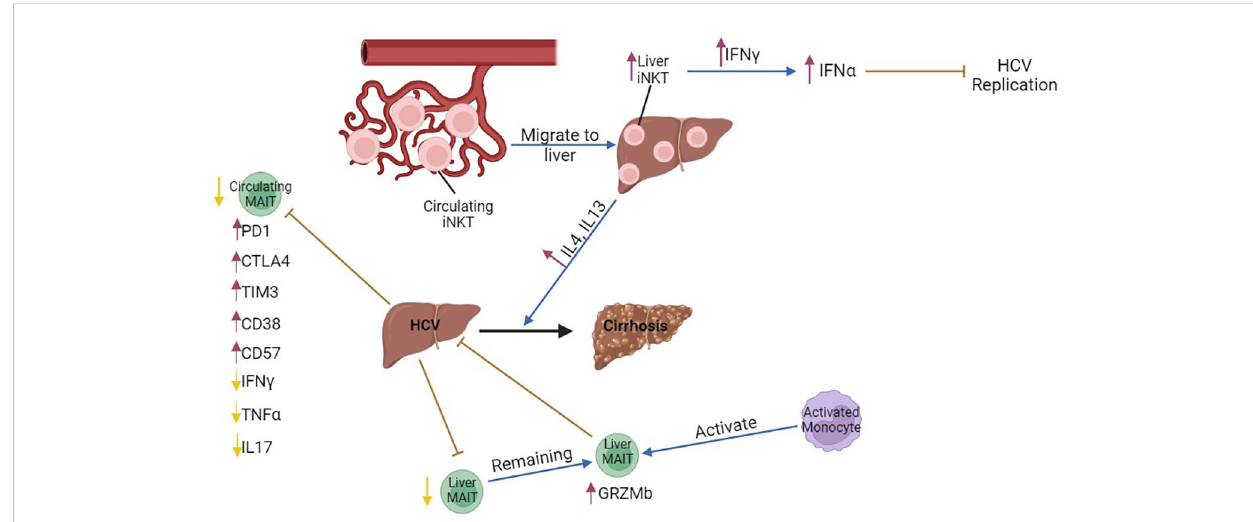
FIGURE 2 The role of MAIT and iNKT cells in chronic HCV infection. The number of circulating iNKT cells is lower compared to that of hepatic iNKTs in chronic HBV, possibly indicating that peripheral iNKT cells migrate from the circulation to the liver and produce increased amounts of IFN g during transition to cirrhosis. Liver iNKT cells show increased production of type I interferons, IFN a and IFN b , through increased production of IFN g and, thus, inhibit HCV replication in the acute phase of the disease. Circulating MAIT cells are decreased, and express the exhaustion markers PD1, CTLA4 and the chronic activation marker CD38. However, they produce lower amounts of IFN g , TNF a , and IL17. Liver MAIT cells are decreased, while the remaining MAIT cells are activated and inhibit chronic HCV infection. Hepatic MAIT cells are activated by monocytes. purple arrows, increase; yellow arrows, decrease; brown arrows, inhibition; blue arrows, promotion, Black arrow, progression of the